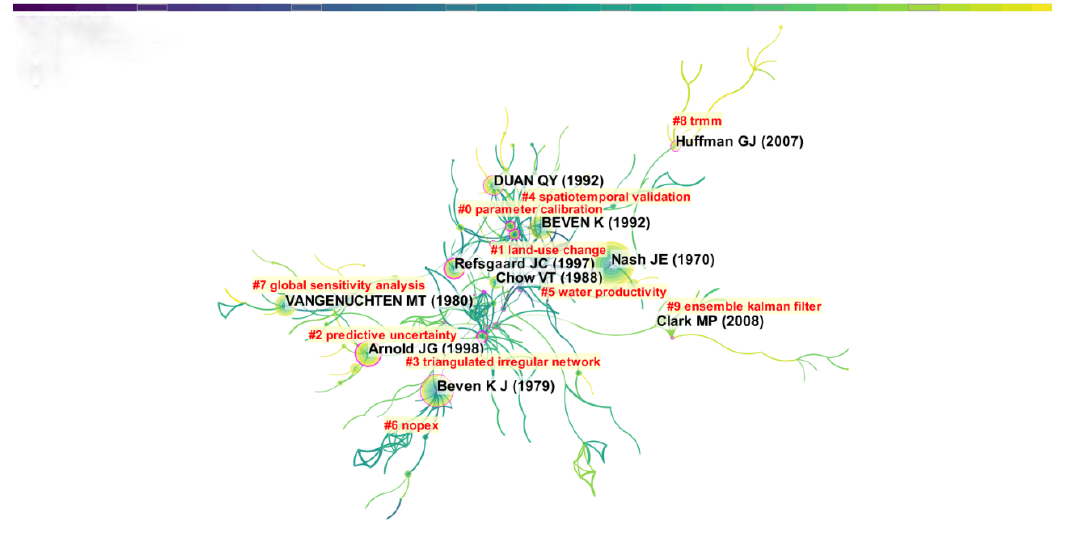
Figure 7. References co-citation map. Table 2. Major clusters of co-cited references.